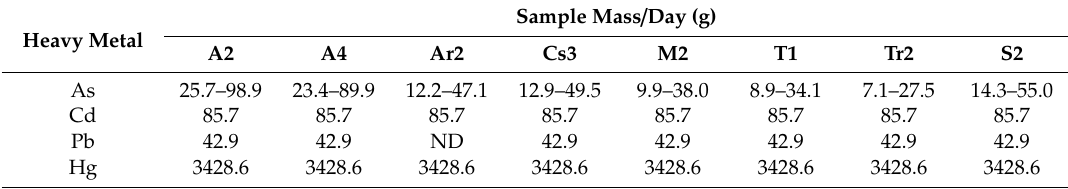
Table 4. Sample mass that can be consumed by day for heavy metals